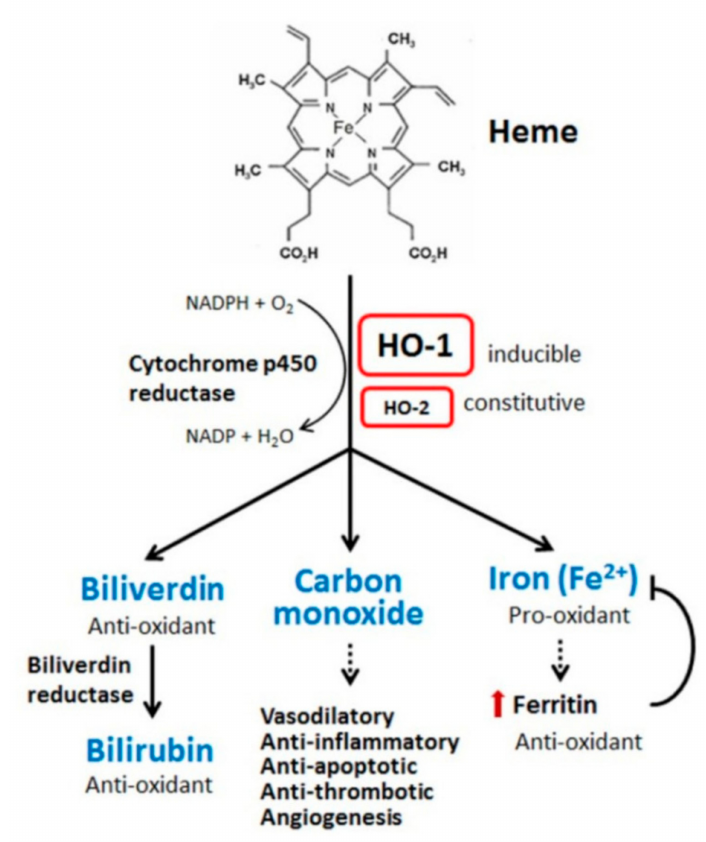
Figure 1. Heme oxygenase (HO-1)-mediated degradation of heme. HO-1 degrades heme into biliverdin, which is subsequently metabolized by biliverdin reductase into bilirubin, a potent physiological antioxidant. The processing of heme by HO-1 additionally releases Fe(II) ferrous iron, which is sequestered by ferritin, a protein that reduces Fe(II) toxicity, and CO, which mediates vasodilatory, anti-inflammatory, anti-apoptotic, anti-thrombotic and pro-angiogenic activities, which collectively constitute a major cytoprotective adaptive response to both external and endogenous stressors. Figure is adapted from Shih-Kai Chiang et al.